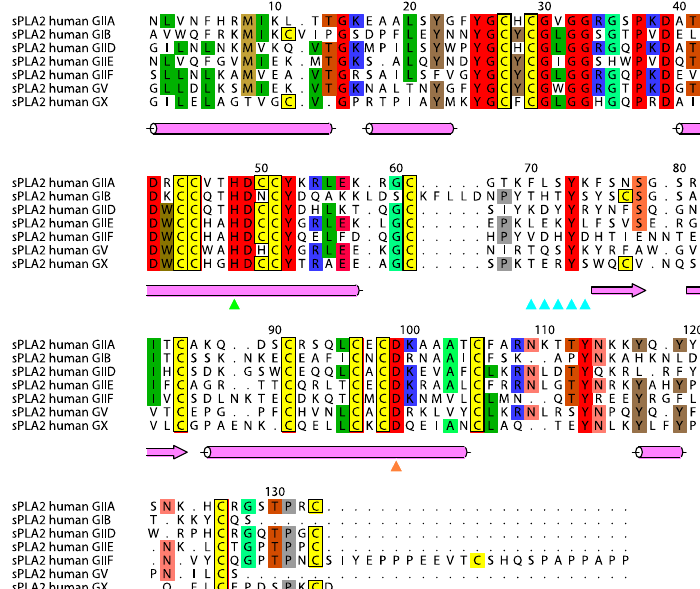
Figure 1. Sequence alignments of seven human secreted phospholipases A 2 . Overall the locations of